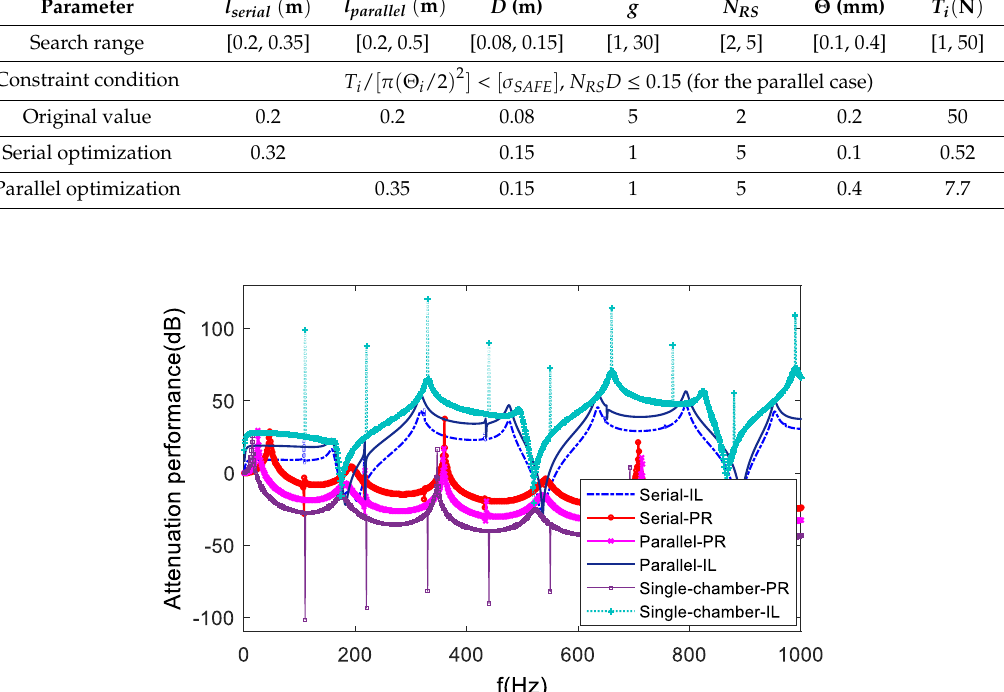
Table 7. Parameter information for multiple-chamber in specific frequency optimization.